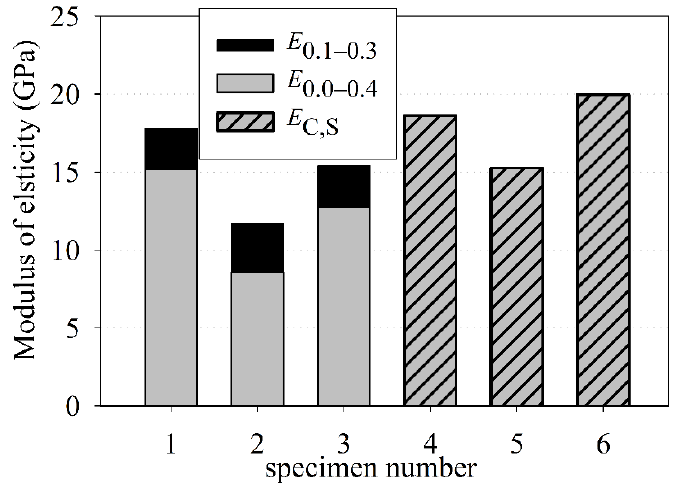
Figure 9. Modulus of elasticity in compression vs. dry density.